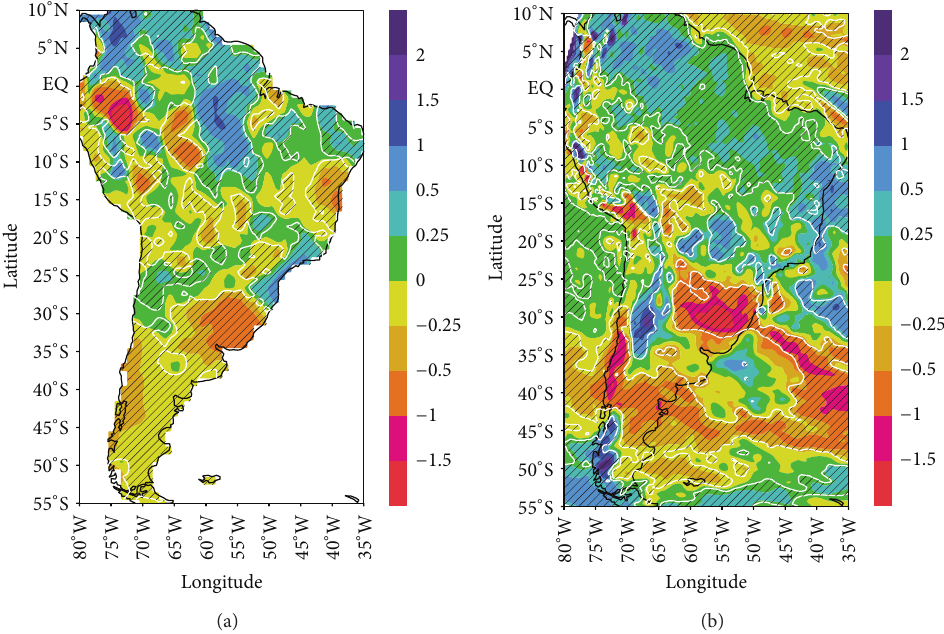
Figure 20: Precipitation anomaly (mmday −1 ) for HCSA poleward expansion cases in the period 1996–2011 based on the (a) GPCC dataset and (b) RegCM4 simulation. Contour intervals are 0.25 mmday −1 with hatching indicating regions statistically significant above the 95% confidence level as determined by two-tailed Student’s 𝑡 -test.